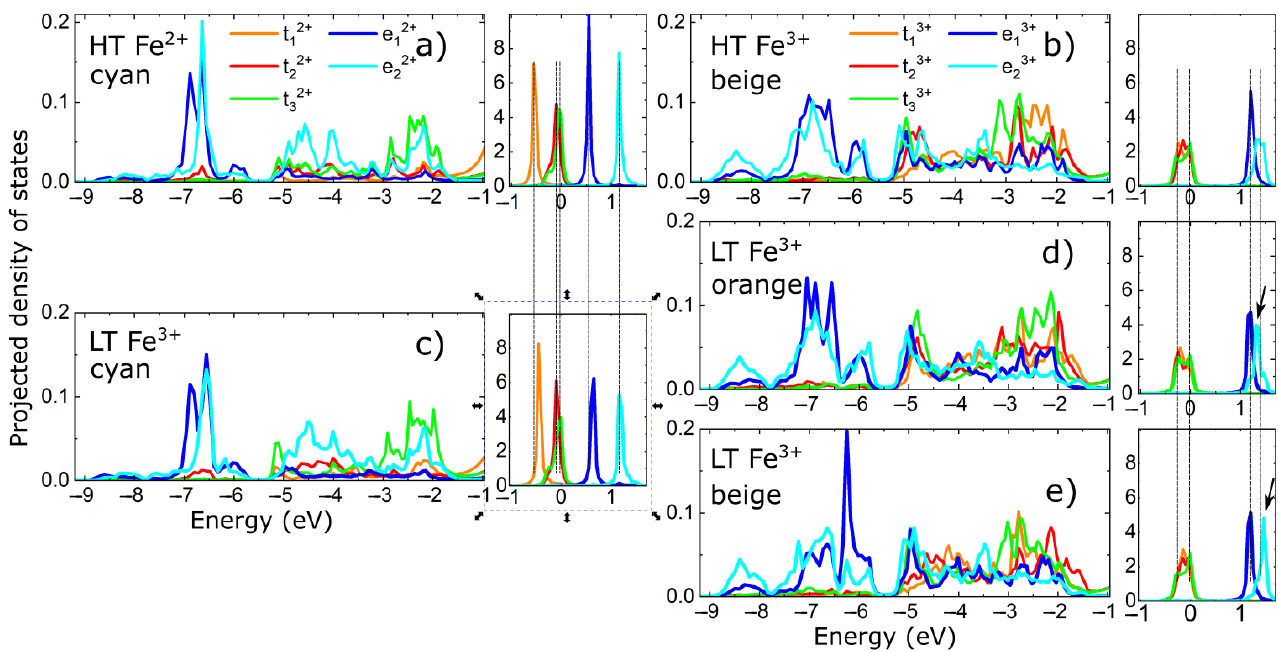
Figure 8. Projected density of states for the Fe d- orbitals: Panels ( a,b ) show the Fe–d projected density of states for the HT unit cell; panels ( c – e ) show the Fe–d projected density of states for the LT unit cell. Fermi energy is represented by the 0 value on the energy axis; panels ( c ) and ( a ) have the same legend; panels ( d ) and ( e ) also have the same legend as panel ( a ). Dotted vertical lines show the correspondence between the peaks in the PDOS computed for the HT and LT unit cell; black arrows in panels ( d ) and ( e ) show the opposite energy shifts in the LT e 23+ PDOS peak’s position with respect to the HT PDOS peak.